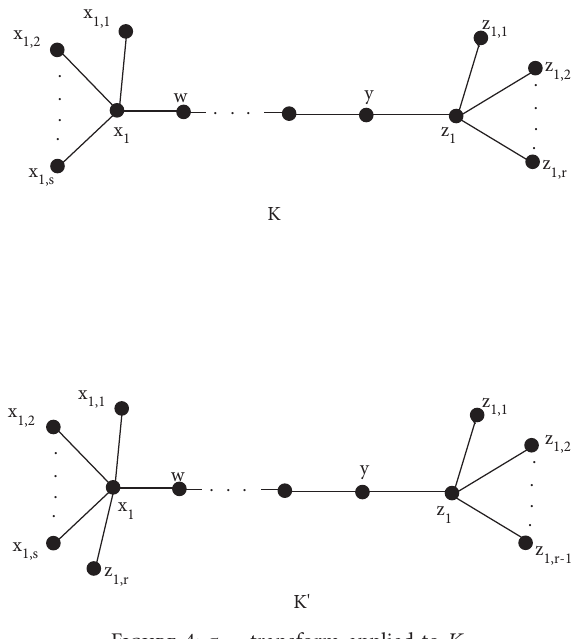
Figure 4: τ − transform applied to K 4